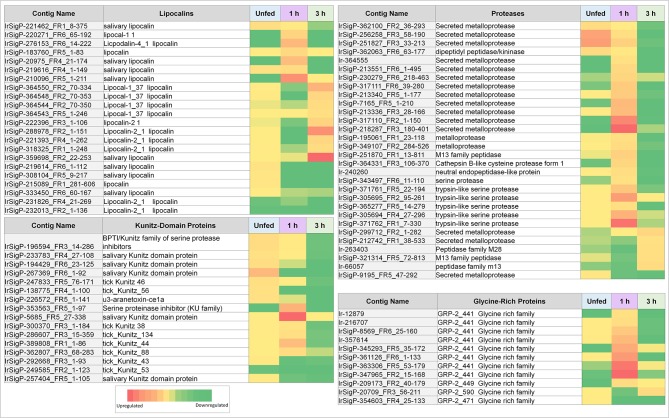
Heatmaps of several categories of genes identified in salivary glands of Ixodes ricinus ticks as up or down regulated in response to TBEV infection, including lipocalins, proteases, and protease inhibitors (largely Kunitz-type). Regulation is generally most influenced at a single timepoint, often as the inverse of the pattern seen in other timepoints. Expression in each category is also not consistent between proteins, indicating that expression of each individual gene is not equivalent and under complex regulatory control.